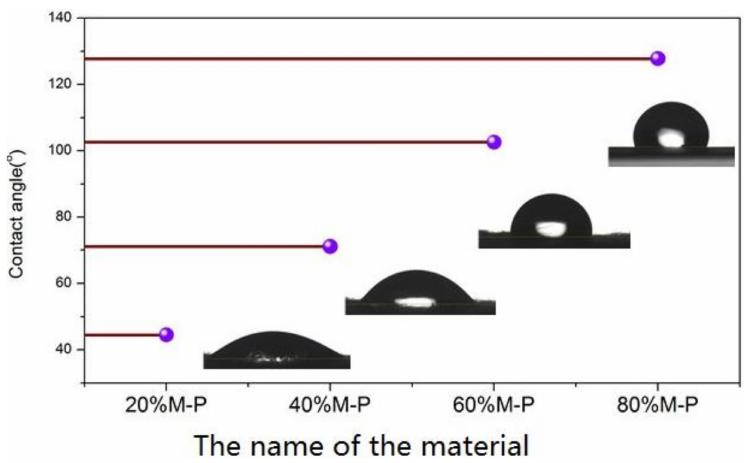
Figure 7. Contact angles of honeycomb fibers with different OPM contents.